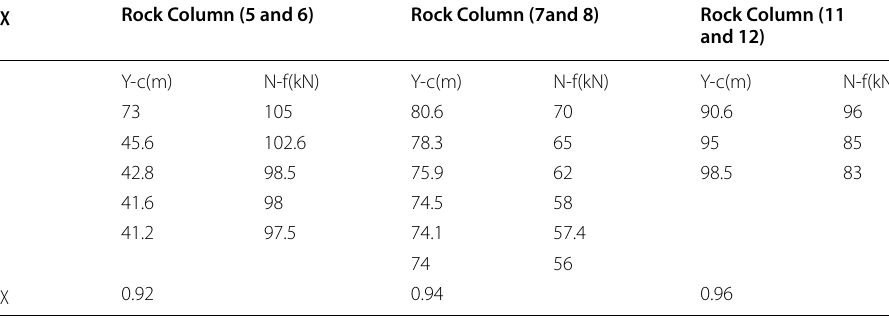
Table 3 Magnitude and location of normal force of contacts between adjacent rock columns (blocks) above the weak